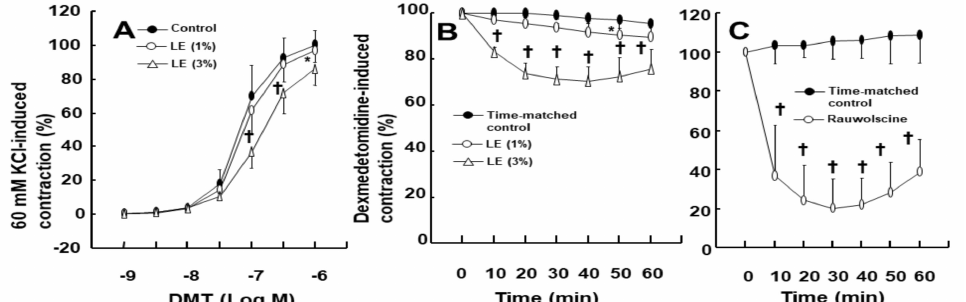
Figure 3. ( A ): Effect of lipid emulsion (LE) on the dexmedetomidine (DMT)-induced contraction in the endothelium-intact rat aorta pretreated with N w -nitro-L-arginine methyl ester (L-NAME, 10 − 4 M). Data ( n = 6) are shown as mean ± standard deviation and expressed as the percentage of isotonic 60 mM KCl-induced contraction. 60 mM KCl-induced contraction was 1.78 ± 0.26, 1.85 ± 0.31, and 1.75 ± 0.11 g for control, 1 and 3% LE, respectively. n indicates the number of rats from which the thoracic aortae were obtained. * p < 0.05 and † p < 0.001 versus control. ( B ): Effect of LE on the DMT (10 − 6 M)-induced contraction in the endothelium-denuded rat aorta pretreated with L-NAME. Data ( n = 8) are shown as mean ± standard deviation and expressed as the percentage of DMT (10 − 6 M)-induced contraction. DMT (10 − 6 M)-induced contraction was 1.61 ± 0.31, 2.12 ± 0.47, and 1.94 ± 0.27 g for time-matched control, 1 and 3% LE, respectively. n indicates the number of isolated rat aorta. * p < 0.05 and † p < 0.001 versus time-matched control. ( C ): Effect of rauwolscine (3 × 10 − 6 M) on the DMT (10 − 6 M)-induced contraction in the endothelium-denuded rat aorta. Data ( n = 7) are shown as mean ± standard deviation and expressed as the percentage of DMT (10 − 6 M)-induced contraction. DMT (10 − 6 M)-induced contraction was 1.57 ± 0.43 and 1.71 ± 0.28 g for time-matched control and rauwolscine, respectively. n indicates the number of isolated rat aorta. † p < 0.001 versus time-matched control. LE (1% and 3%) decreased the DMT concentration (10 − 9 , 10 − 8 , 10 − 7 , and 10 − 6 M) in a concentration-dependent manner (Figure 4; p < 0.001 vs. control; p < 0.05 vs. 1% LE plus DMT).